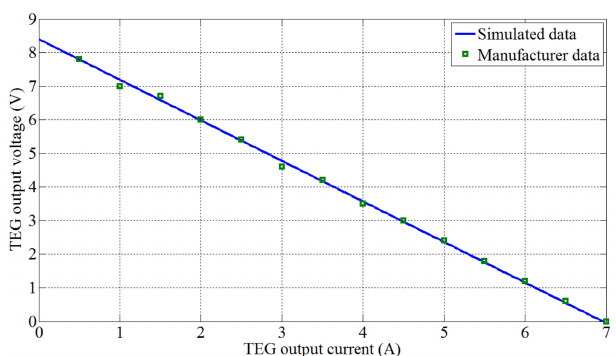
Figure 4. TEG1-12611-6.0 output voltage against the output current.